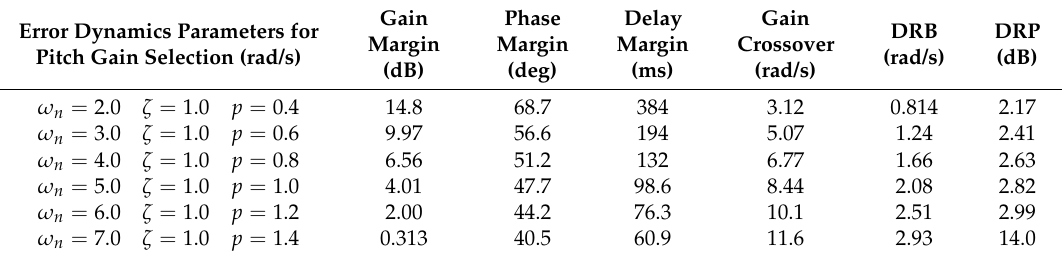
Table 4. Variation in pitch axis stability margins and disturbance rejection performance with variation in pitch axis gain parameters.